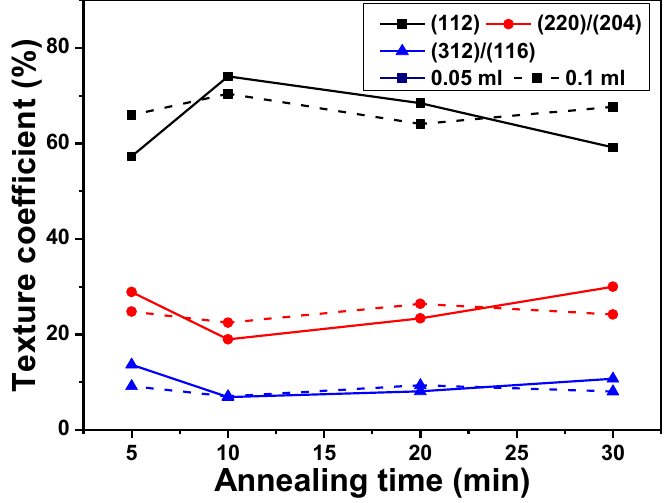
Figure 4. Texture coefficients of the CIS absorber layers a function of annealing time and using solution